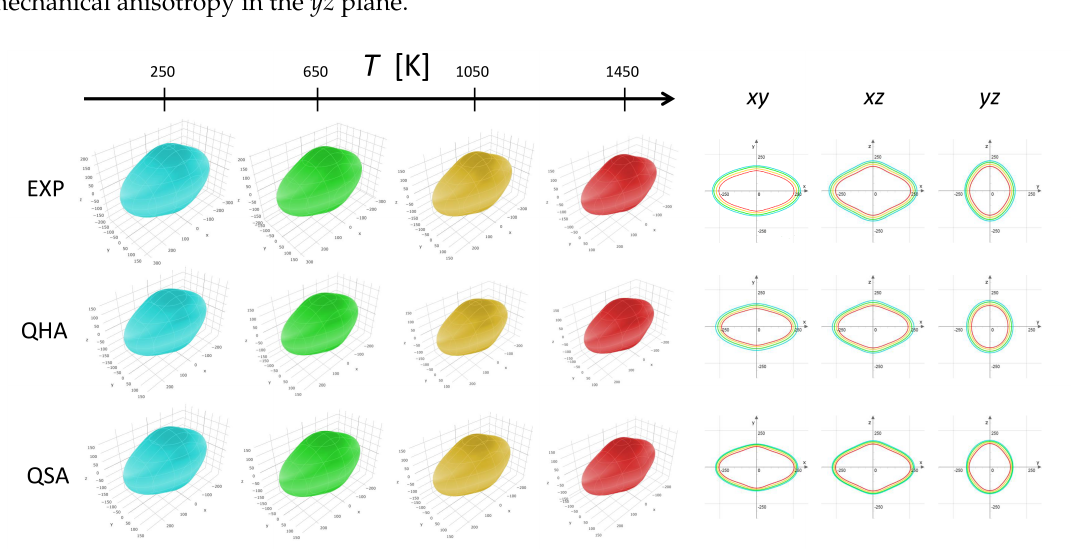
Figure 4. Effect of temperature on the Young modulus of forsterite. Left : 3D representation of the spatial dependence of the Young modulus as a function of temperature from experimental elastic constants, quasi-harmonic computed constants, and quasi-static computed constants. Right : 2D projections of the Young modulus in three different planes ( xy , xz and yz ) as a function of temperature (blue for 250 K, green for 650 K, yellow for 1050 K and red for 1450